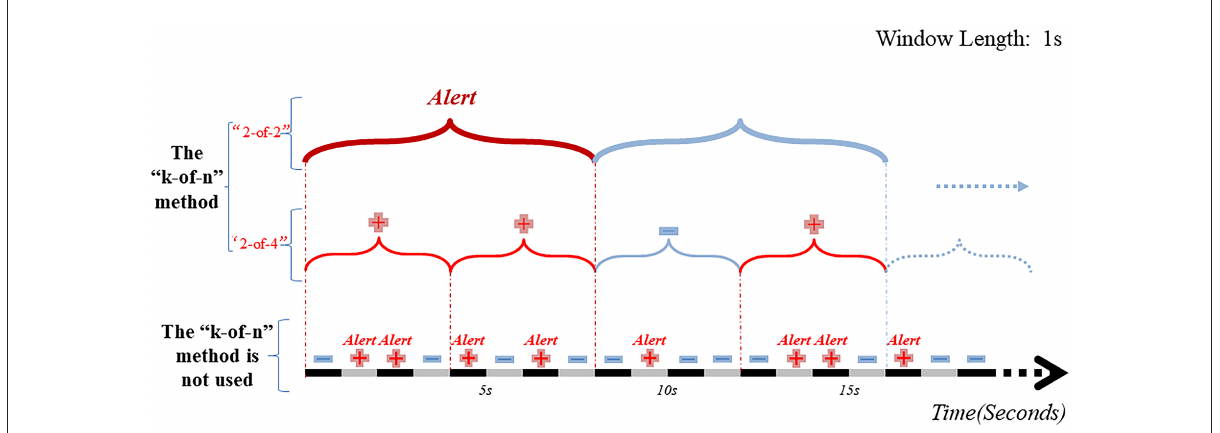
FIGURE5 Schematic diagram of EEG window segment and post-processing hierarchy. Without using the “ k -of- n ” method, there will be 7 warning messages in the range of 0–16 sec. And after passing the two-layer “ k -of- n ” method, the model will send warning messages only at the 8th sec. The results show that the “ k -of- n ” method can greatly reduce invalid and overlapping warning